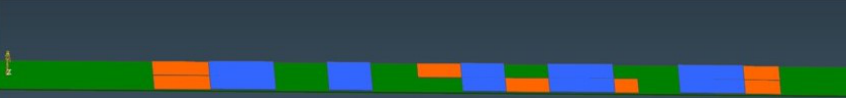
Figure 13. Simulation environment for uneven terrain (Case 2): 30 mm (Orange), 60 mm